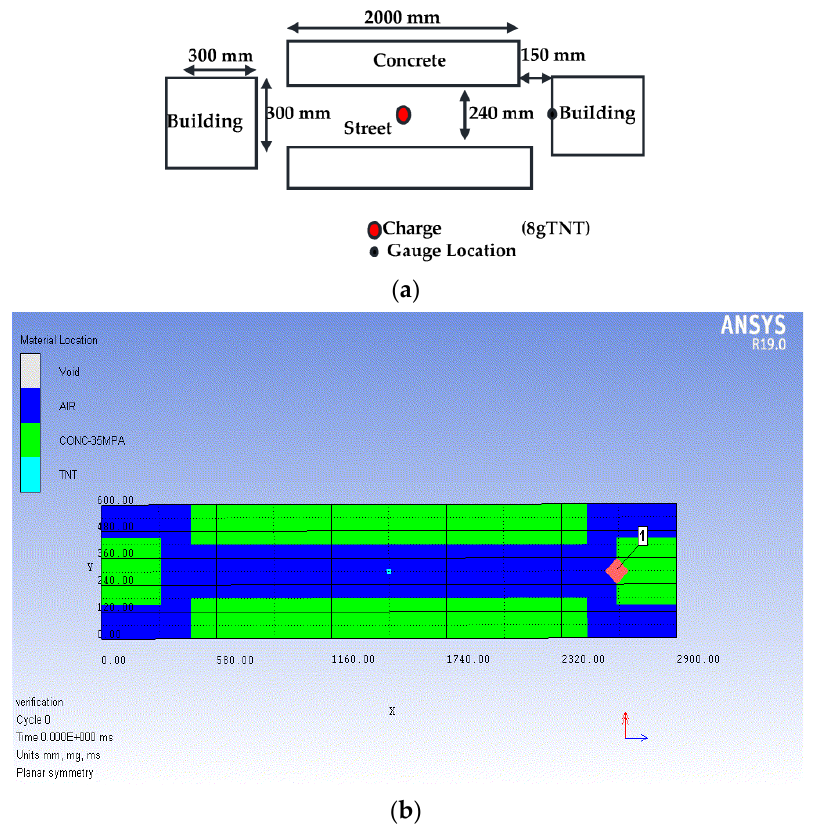
Figure 6. Details of the air blast experiment. ( a ) schematic diagram of the air blast physical [80]. ( b ) Numerical modelling of the experiment.